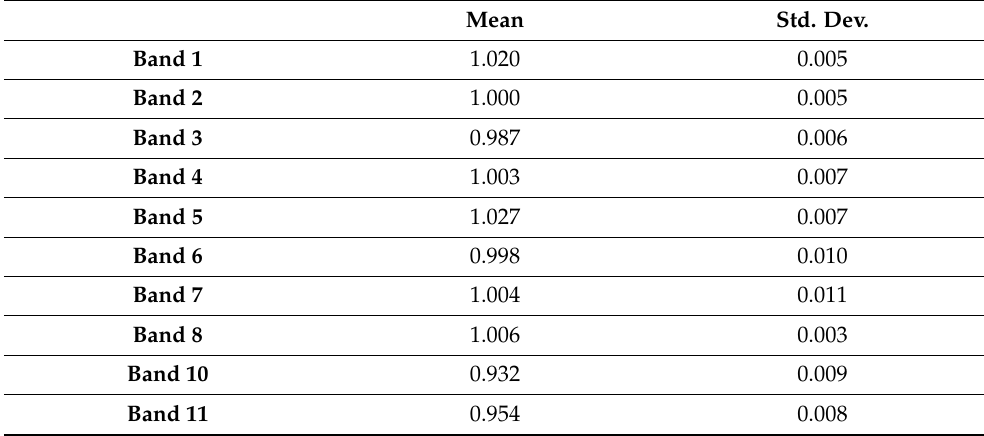
Table 7. Weighted variance estimator—radiance.